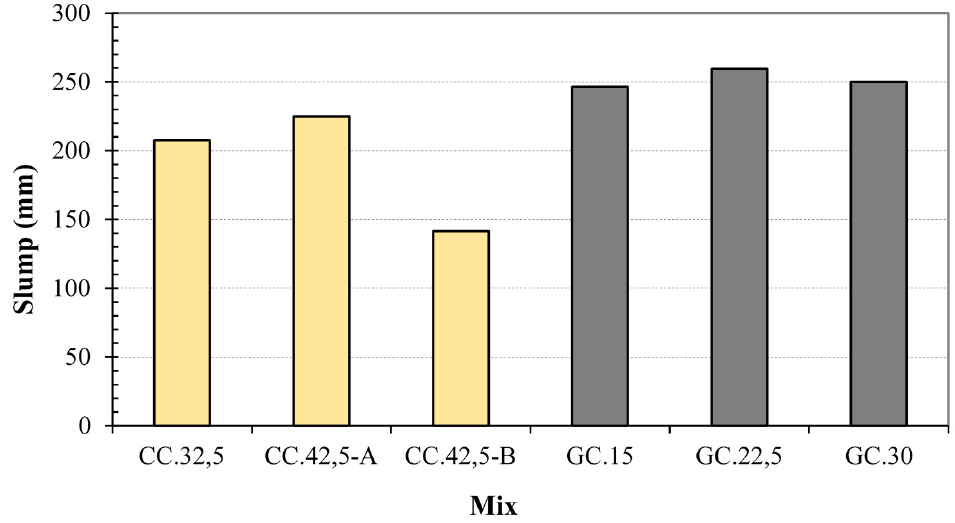
Figure 6. Workability (slump test) of the mixes.